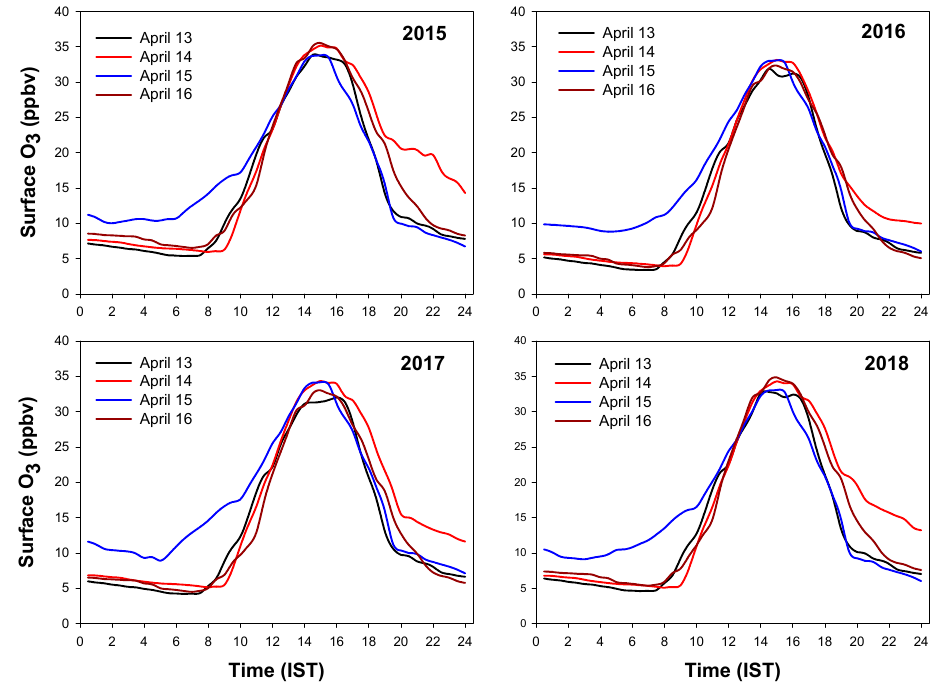
Figure 5. Diurnal variation of surface O 3 at Kannur during pre-, post-, and Vishu days for four consecutive years of 2015, 2016, 2017, and 2018.